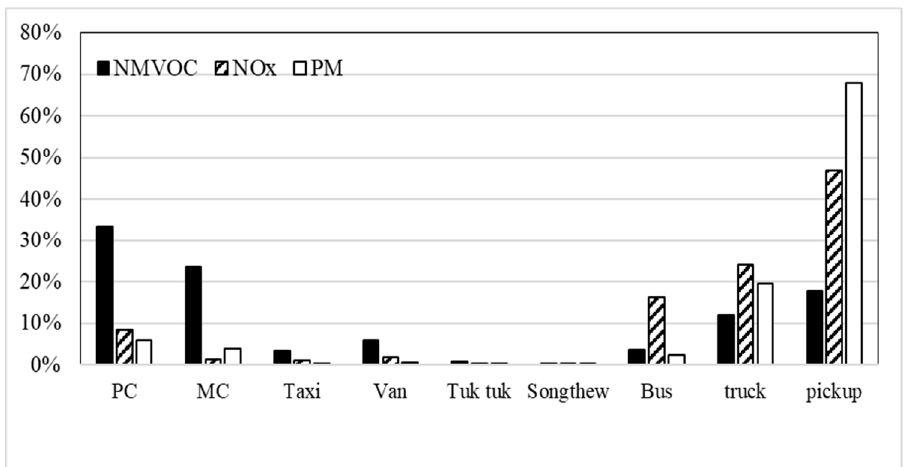
Figure 3. Emission shares of different on-road vehicle fleets in the BMR domain based on our emission inventory data. Source: Ha Chi, 2018 (see text) PC: private car; MC: motorcycle; Songthew: shared taxi with two bench seats adapted from a light-duty diesel vehicle and used as a feeder from the village to the main transportation system; Tuk tuk: three-wheeled motorized vehicle used as a taxi and using LPG and CNG as fuel in BMR.